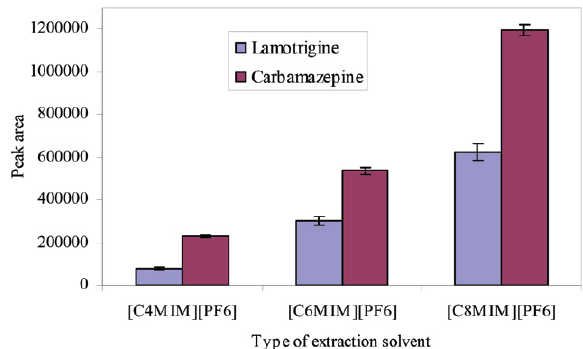
Figure 3. Effect of type of extraction solvent on the extraction effi- ciency, Extraction conditions: extraction solvent volume: 30 µL; dispersive solvent: methanol; dispersive solvent volume: 100 µL; concentration of NaCl ( w/v ): 1.0%,